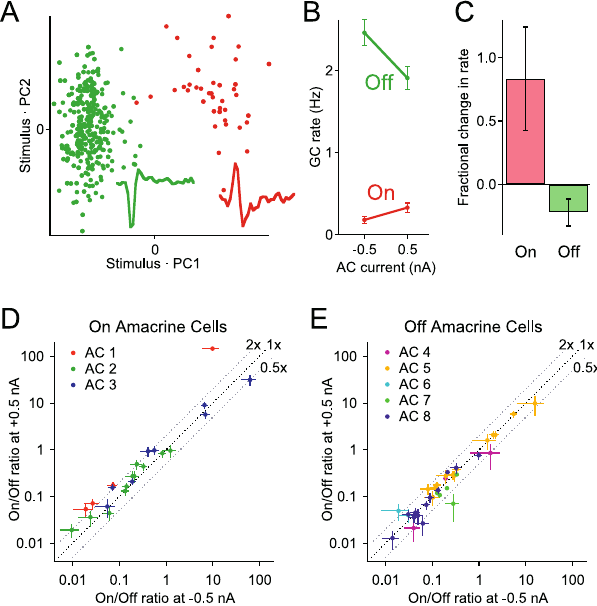
Figure 9. On-Transient Amacrine Cells Control the On/Off Balance of Ganglion Cells An amacrine cell was alternatingly depolarized and hyperpolarized with injection of 6 0.5 nA current. Simultaneously, spikes were recorded from ganglion cells under stimulation with a flickering spot (Figure 1A), but no grating. (A) Spike-triggered stimuli for an On-Off ganglion cell, plotted as in Figure 4B, revealing two clusters of On spikes and Off spikes. (B) The firing rate of On spikes and Off spikes, derived from the clusters of (A), during periods of amacrine cell depolarization ( þ 0.5 nA) and hyperpolarization ( (cid:2) 0.5 nA). (C) Fractional change in the firing rate of On spikes and Off spikes during depolarization. Note that the On/Off ratio is larger by a factor of 2.4 during depolarization. (D) The effects of stimulating On-transient amacrine cells. For each of three On-transient amacrine cells (AC 1–AC 3), several nearby On-Off ganglion cells were analyzed. For each of these, the graph shows the On/ Off ratio during amacrine cell depolarization, plotted against the On/Off ratio during hyperpolarization. (E) The effects of stimulating Off amacrine cells. Two Off-transient and three Off-sustained amacrine cells were stimulated, and the change in On/Off ratio of nearby ganglion cells is plotted as in (D). Error bars in (B–E) represent one standard deviation uncertainty (see Materials and